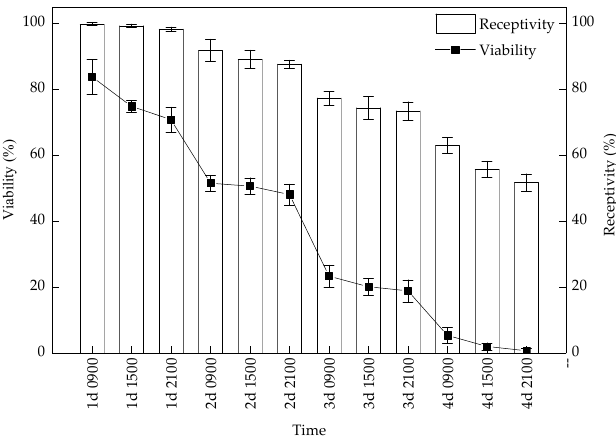
Figure 2. Pollen viability and stigma receptivity in Schima superba (S.E. percentage per day).